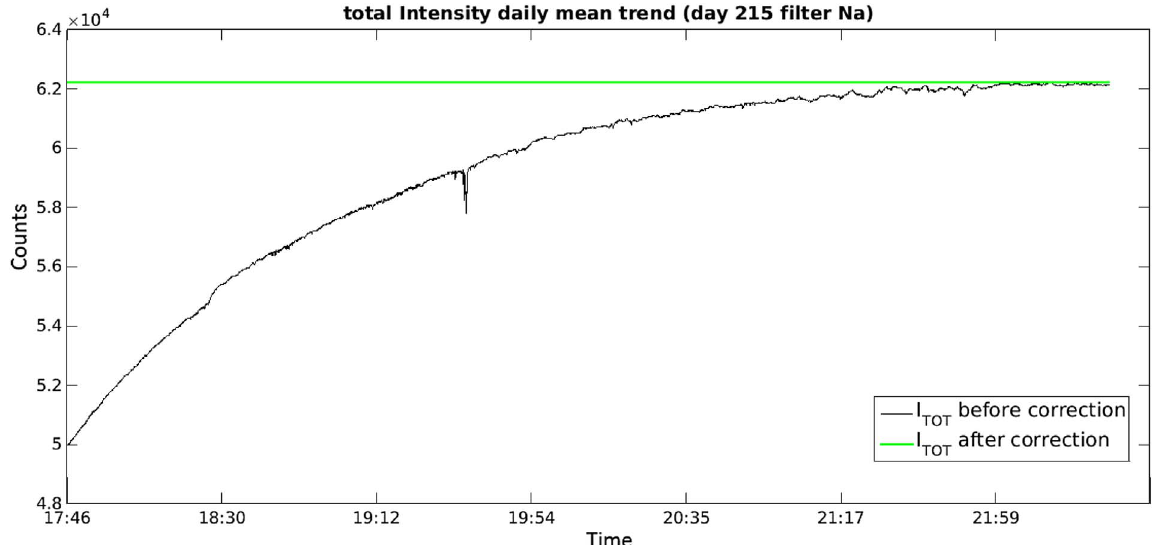
Fig. 5. I TOT ( t ) during a ’ 5 h long observation run. The black and green lines show the I TOT ( t ) before and after the correction procedure, respectively.